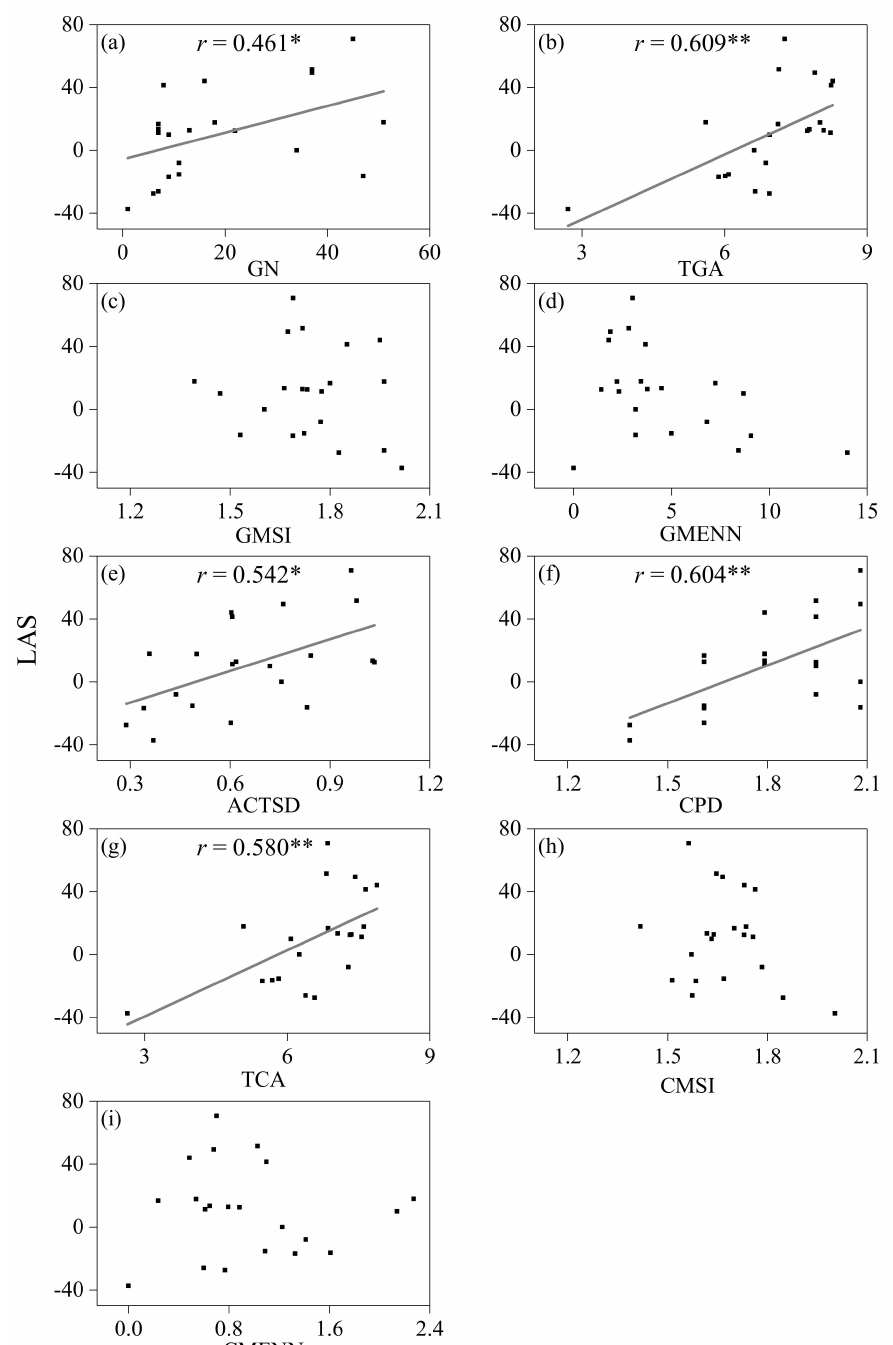
Figure 8. Relationship between LAS with ( a ) GN, ( b ) TGA, ( c ) GMSI, ( d ) GMENN, ( e ) ACTSD, ( f ) CPD, ( g ) TCA, ( h ) CMSI, and ( i ) CMENN, in each plot. ACTSD–autumn color-leaved tree species diversity; CMENN–mean Euclidean nearest-neighbor distance of color-leaved patches; CMSI–mean shape index of color-leaved patch; CPD–color-leaved patch diversity; GMENN–mean Euclidean nearest-neighbor distance of gaps; GMSI: mean shape index of gaps; GN–number of gaps; LAS–landscape aesthetic service; TCA–total color-leaved patch area; TGA–total gap area. Solid lines indicate that there is a significant relationship between landscape aesthetic service with gap charac- teristics, ACTSD, and color-leaved patch structure attributes; if there is no significant relationship, it is not marked in the figure; * and ** indicate p < 0.05 and p < 0.01,